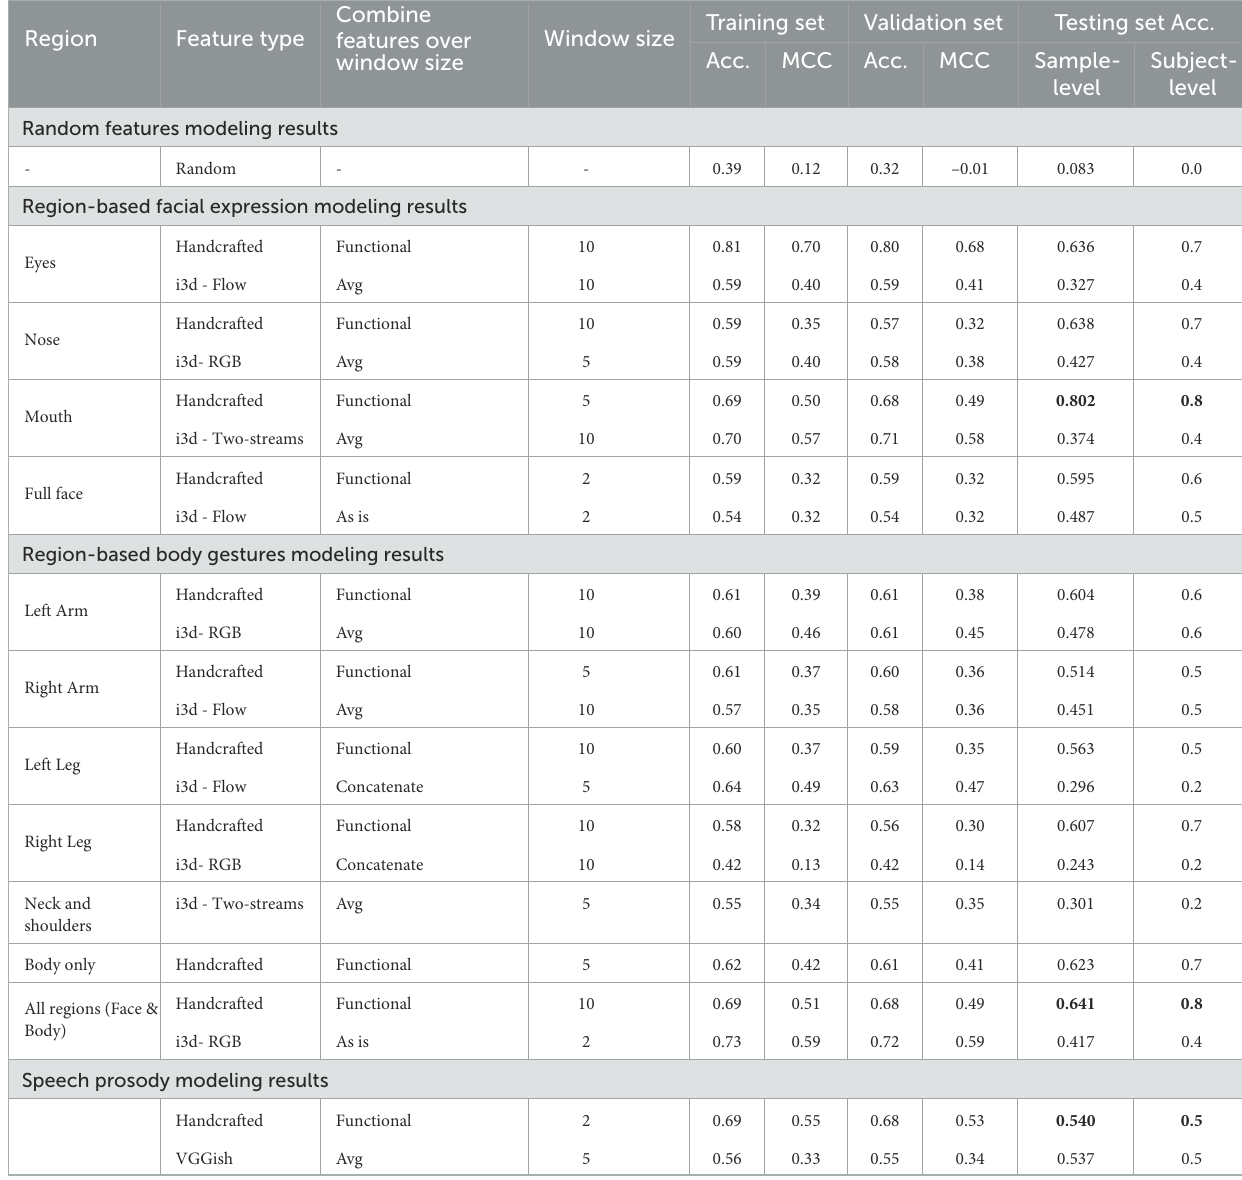
TABLE 3 Single modality modeling results-Showing (1) Facial Expression: the superiority of the mouth region in distinguishing suicide risk level, (2) Body Gesture: fusing all body regions with body orientation in handcrafted features provides informative behavior for better model performance, (3) Speech Acoustic: handcrafted features continuously outperforming deep representation features, and (4) all modalities outperformed the random features.